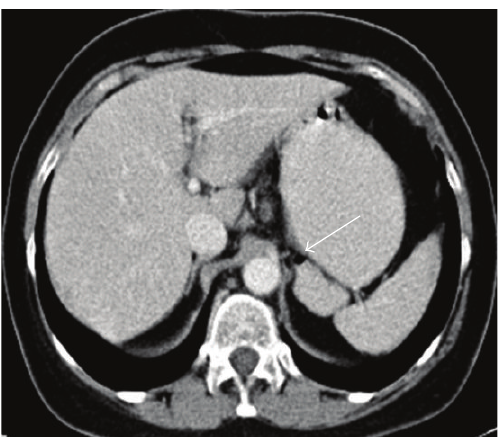
Figure 12: Axial contrast enhanced CT image with oral contrast medium reveals a hyperdense mass posterior to the stomach and medial to the spleen. The gas bubble anterior to the mass (arrow) helps gastric diverticulum in differentiating it from an accessory spleen.